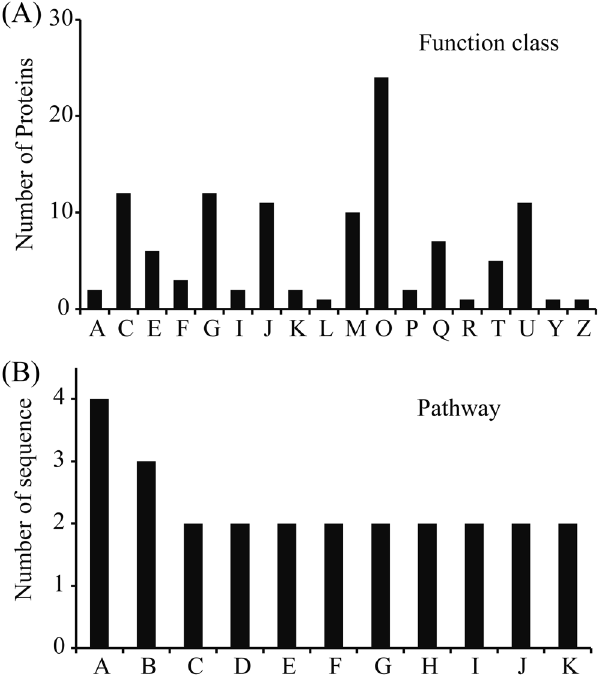
Figure 5. COG classification and KEGG pathway analysis of DEPs between PT and NT maize seeds. Functional class was produced by COG ( A ), and the abbreviations in the figure ( A ) are as follows: A, RNA processing and modification; C, Energy production and conversion; E, Amino acid transport and metabolism, Coenzyme transport; F, Nucleotide transport and metabolism; G, Carbohydrate transport and metabolism; I, Lipid transport and metabolism; J, Translation, ribosomal structure and biogenesis; K, Transcription; L, Transcription, Replication, recombination and repair; M, Cell wall/membrane/envelope biogenesis; O, Post- translational modification, protein turnover, and chaperones; P, Inorganic ion transport and metabolism; Q, Secondary metabolites biosynthesis, transport, and catabolism; R, General function prediction only; T, Signal transduction mechanisms; U, Intracellular trafficking, secretion, and vesicular transport; Y, Nuclear structure; Z, Cytoskeleton. The related KEGG pathways were classified into 11 main categories ( B ), and the abbreviations in the figure ( B ) are as follows: A, Amino sugar and nucleotide sugar metabolism; B, Pyruvate metabolism; C, Starch and sucrose metabolism; D, Galactose metabolism; E, Metabolism of xenobiotics by cytochrome P450; F, Histidine metabolism; G, Carbon fixation in photosynthetic organisms; H, Glutathione metabolism; I, Drug metabolism - cytochrome P450; J, Aminobenzoate degradation; K, Pentose and glucuronate